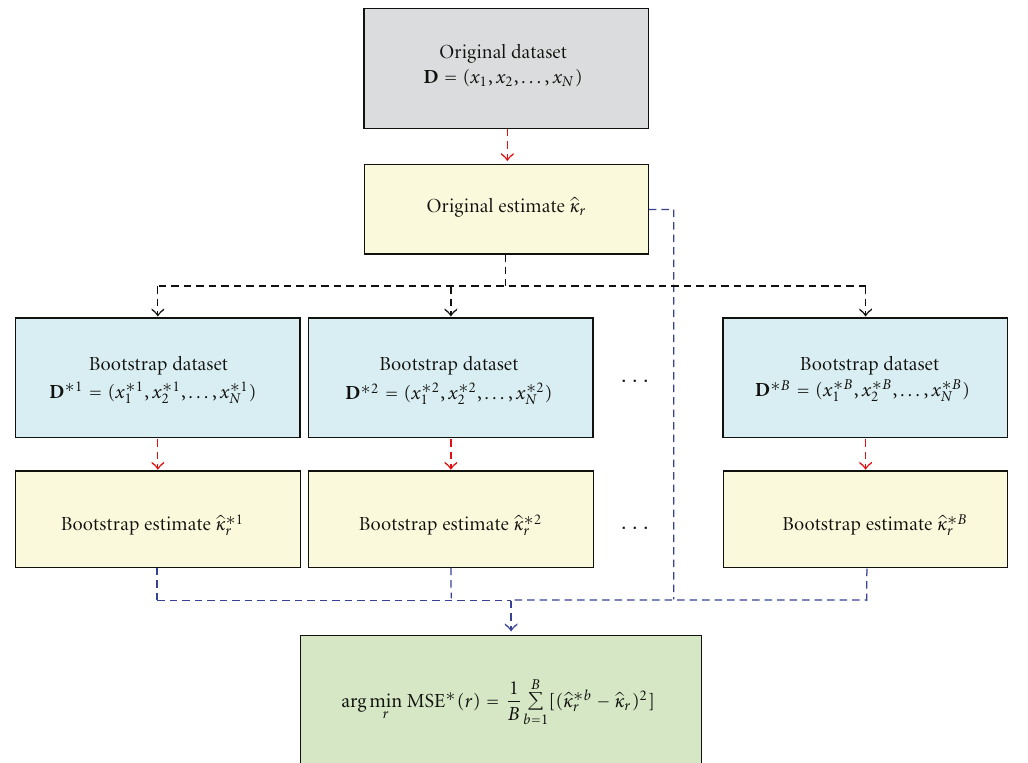
Figure 2: Block diagram of the radius selection algorithm using bootstrap